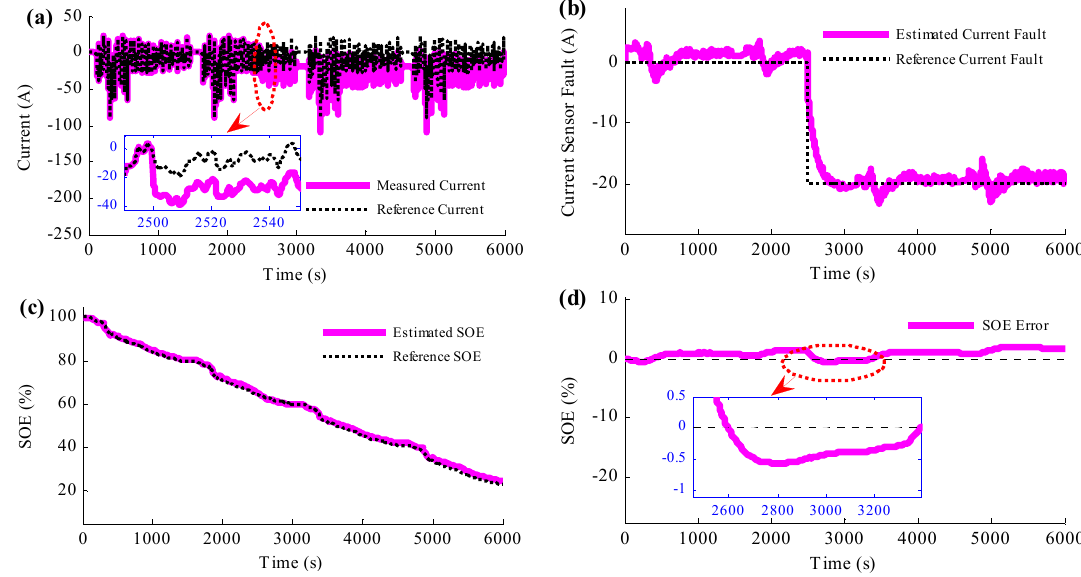
Figure 12. Experimental results when the method to simultaneously detect the current sensor fault and estimate the SOE is applied: ( a ) the current results; ( b ) comparison between the estimated current fault and the reference current fault; ( c ) the SOE estimation results; ( d ) the SOE estimation error results.